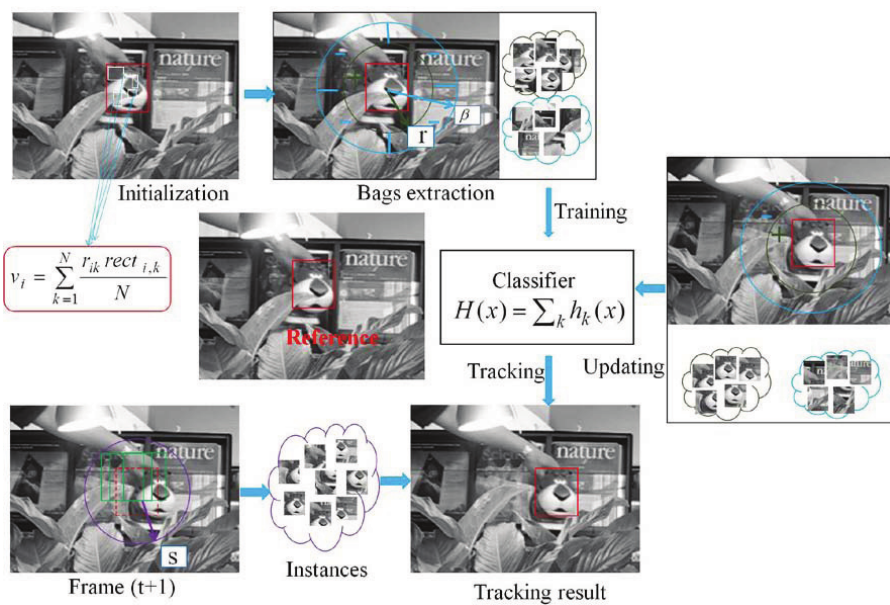
Figure 1. The flow chart of the Kernel based MIL